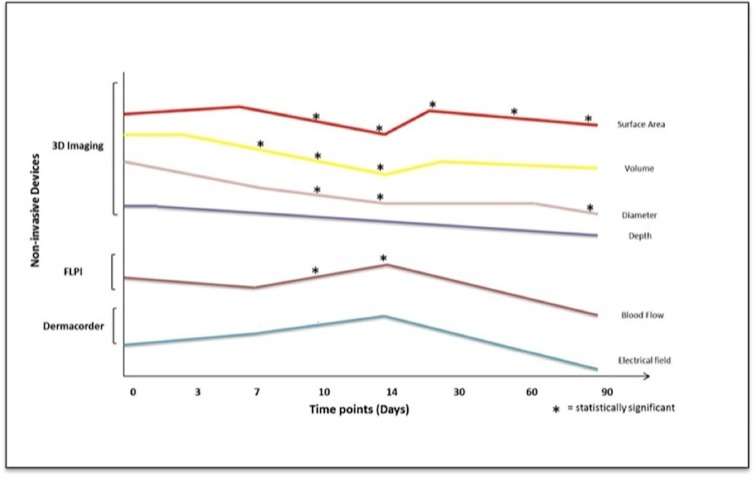
A graph demonstrating a representation of the trends noted.A graph collating the results from this electrical stimulation (ES) temporal punch biopsy study which displays a representation of the trends found for all of the time points combined. Each line represents the trend for the post-ES arm for each parameter and displays the points at which these were statistically significant. The different objective non-invasive devices, which were used are shown on the y-axis and the measurements taken for each are presented by a different colour line on the graph. The statistical significances found are highlighted on the graph (* = statistical significance). 3-dimensional (3D) imaging showed that the wound surface area was significantly lower on days 10, 14, 30 60 and 90 following the application of ES. Wound volume was significantly reduced post-ES on days 7, 10 and 14. Wound diameter was significantly lower on days 10, 14 and 90 following ES. Full-field laser perfusion imaging (FLPI) demonstrated a significant increase in blood flow at days 10 and 14 following the application of ES. Furthermore, the Dermacorder showed that the electrical field (EF) at the wound edges were increased post-ES although not significantly.